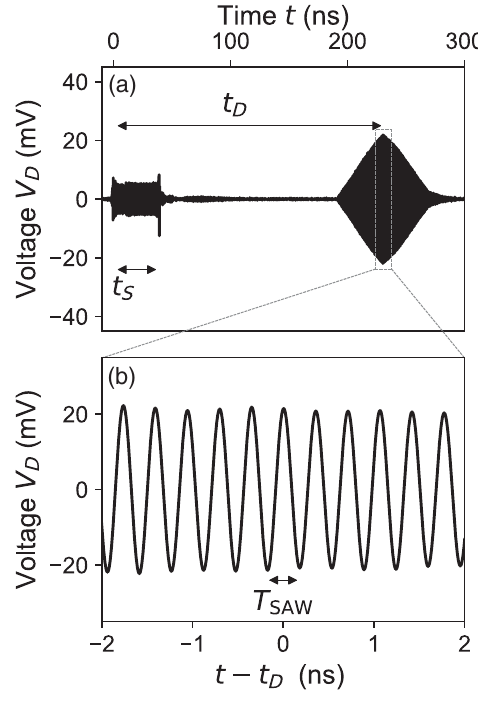
FIG. 11. Time-resolved measurements on regular IDT. (a) Trace of detector response for resonant input signal applied for a duration t S ¼ 40 ns on the regular IDT. The SAW arrives with expected delay t D after initial electromagnetic crosstalk. (b) Zoom in of SAW region at t D